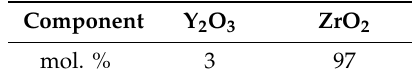
Table 1. Chemical composition of Al 2 O 3 powder. Table 2. Chemical composition of the ZrO 2 powder. Table 2. Chemical composition of the ZrO 2 powder.